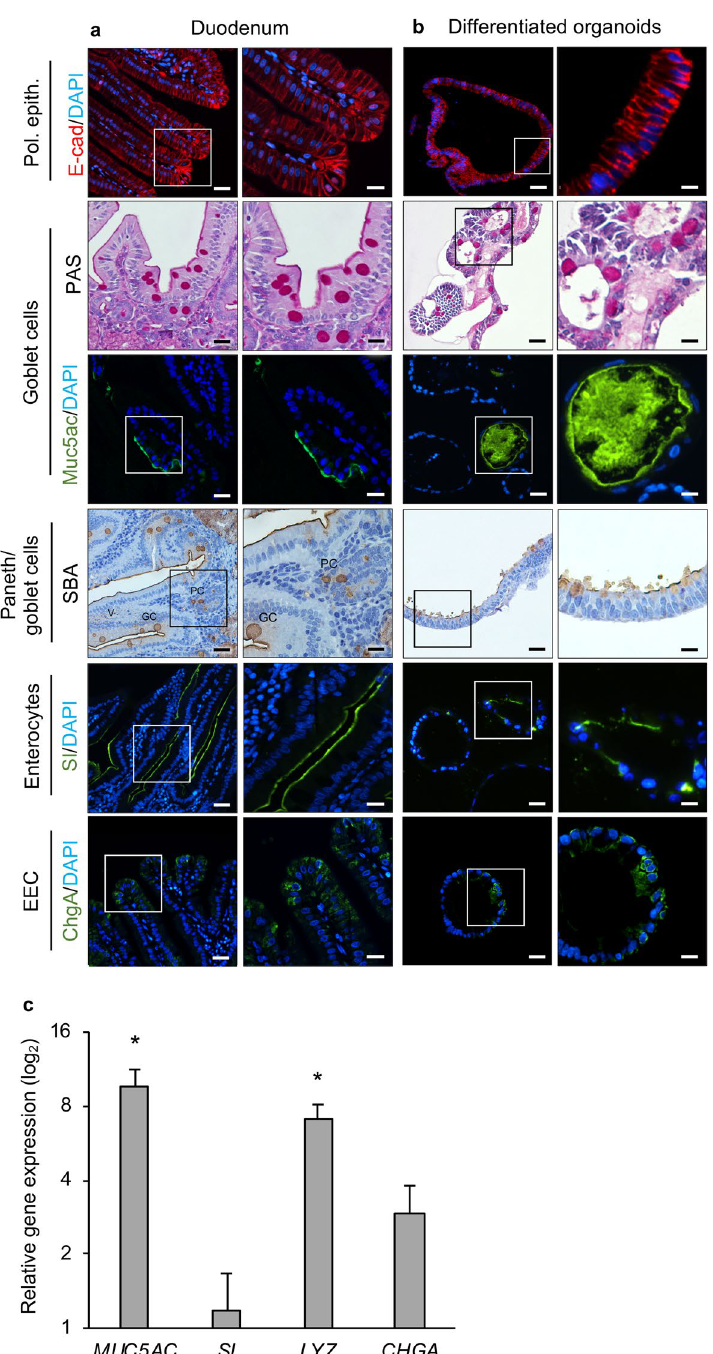
Figure 3. Identification of different cell types in rabbit duodenal tissue and organoids. ( a ) Rabbit duodenal tissue sections and ( b ) rabbit duodenal organoids were immunostained for e-cadherin (red), PAS (magenta), Muc5ac (green), soybean agglutinin (SBA) (brown), sucrase-isomaltase (SI) (green) and chromogranin A (ChgA) (green); nuclei were counterstained with DAPI (blue). Boxed regions are shown at higher magnification in the panels below. Pol. epith., polarised epithelial cells. V, villus. GC, goblet cell. PC, Paneth cell. Scale bars = 100 μm (upper panel) and 200 μm (lower panel). ( c ) Expression of intestinal epithelial maturation- associated genes ( MUC5ac, SI, CHGA and LYZ ) in differentiated organoids. Data are presented as fold change (2 −ΔΔCt ) in gene expression from undifferentiated spheroids, calculated from three individual cell culture wells with three technical RT-qPCR replicates each. Error bars represent standard errors of the mean. Student’s t-test was performed to assess the statistical significance; only statistically significant differences are shown (* p < 0.05). All experiments were conducted in duodenal organoids from a single laboratory